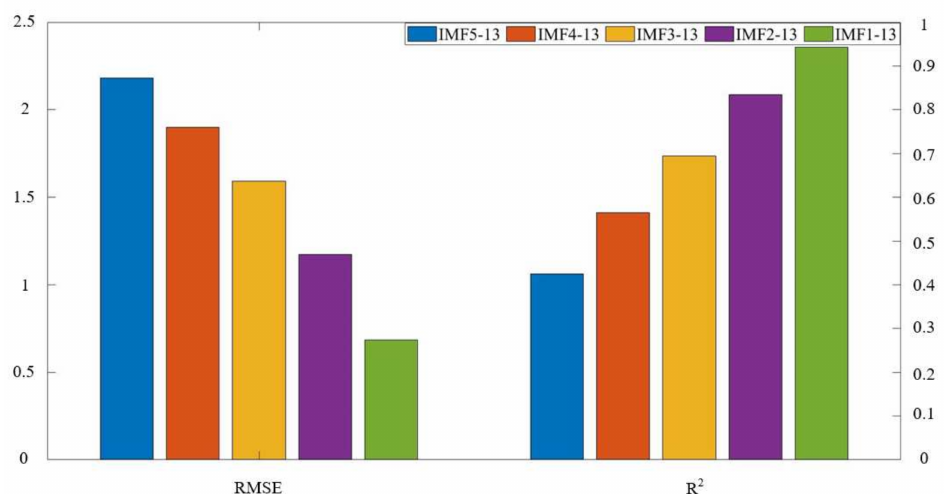
Figure 13. Forecasting index of the reactive power